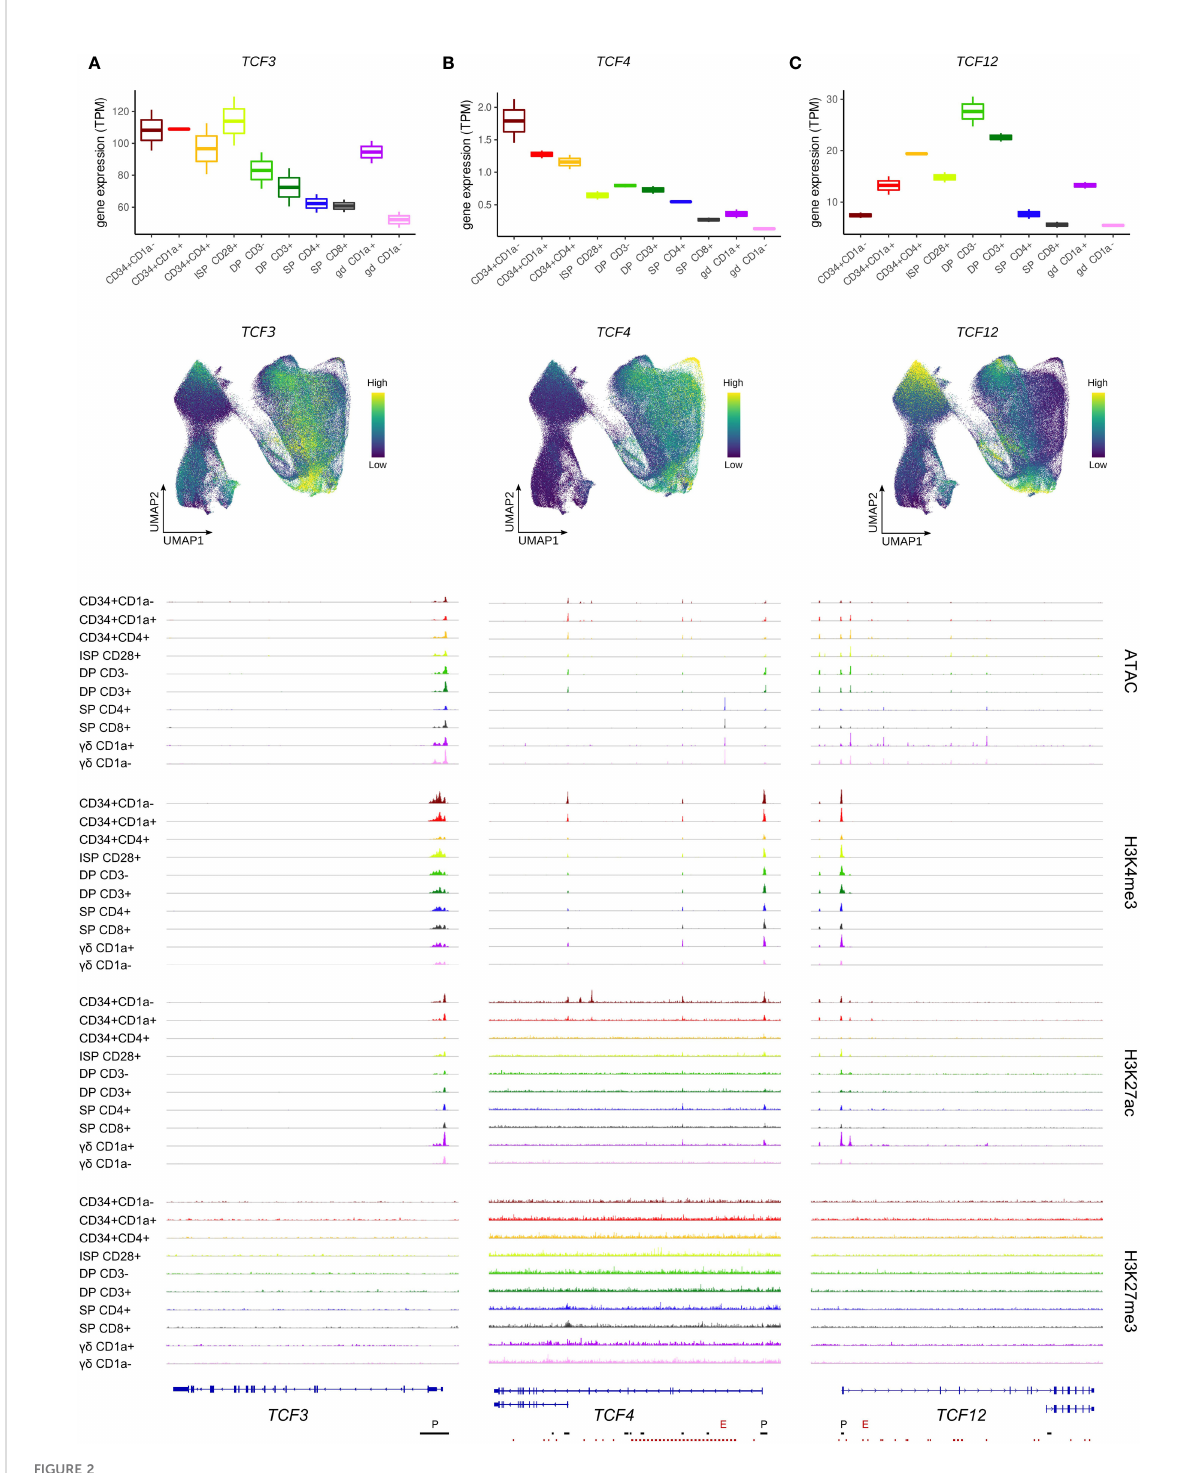
FIGURE 2 Expression of E protein encoding genes throughout human thymocyte development. (A) Transcript levels of TCF3 according to bulk RNA-seq (top) and single cell data (middle), and epigenetic pro fi le at the TCF3 gene locus. (B) Transcript levels of TCF4 according to bulk RNA-seq (top) and single cell data (middle), and epigenetic pro fi le at the TCF4 gene locus. Long and short isoform of TCF4 are shown. (C) Transcript levels of TCF12 according to bulk RNA-seq (top) and single cell data (middle), and epigenetic pro fi le at the TCF12 gene locus. Long (HEBcan) and short isoform (HEBalt) of TCF12 are shown. Locations of promoters (P) and enhancers (E) were retrieved from the Ensembl Regulatory Build and are indicated below the gene structure. UMAP visualizations were generated using imputed